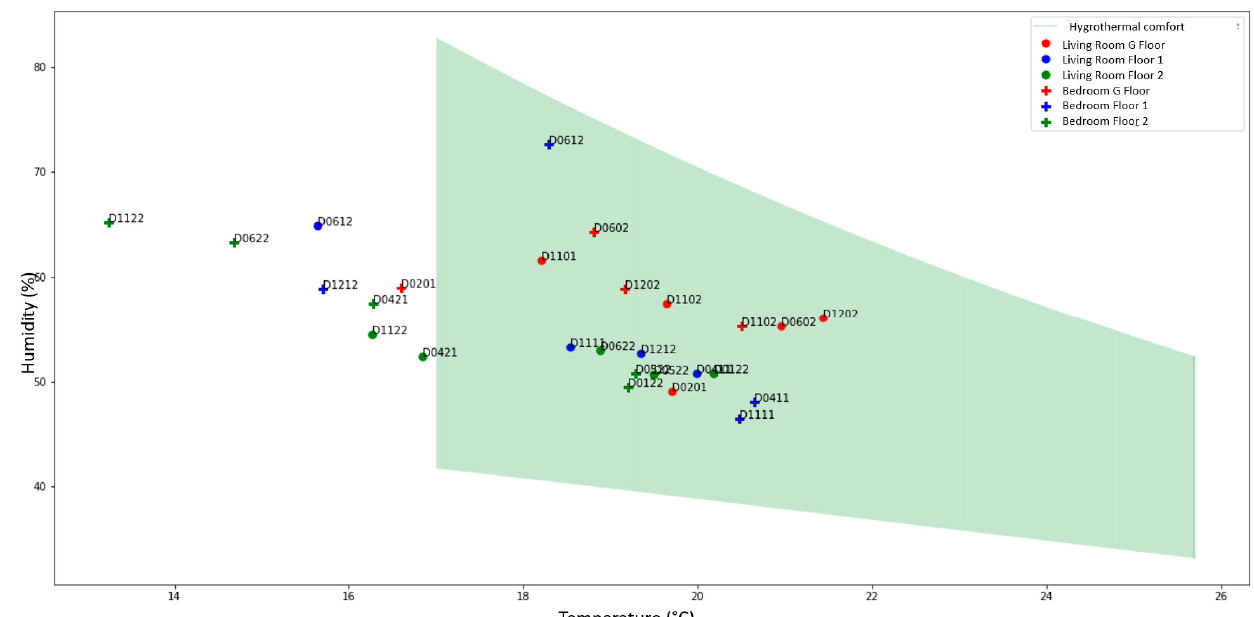
Figure 27. Annual savings in the hot water consumption.